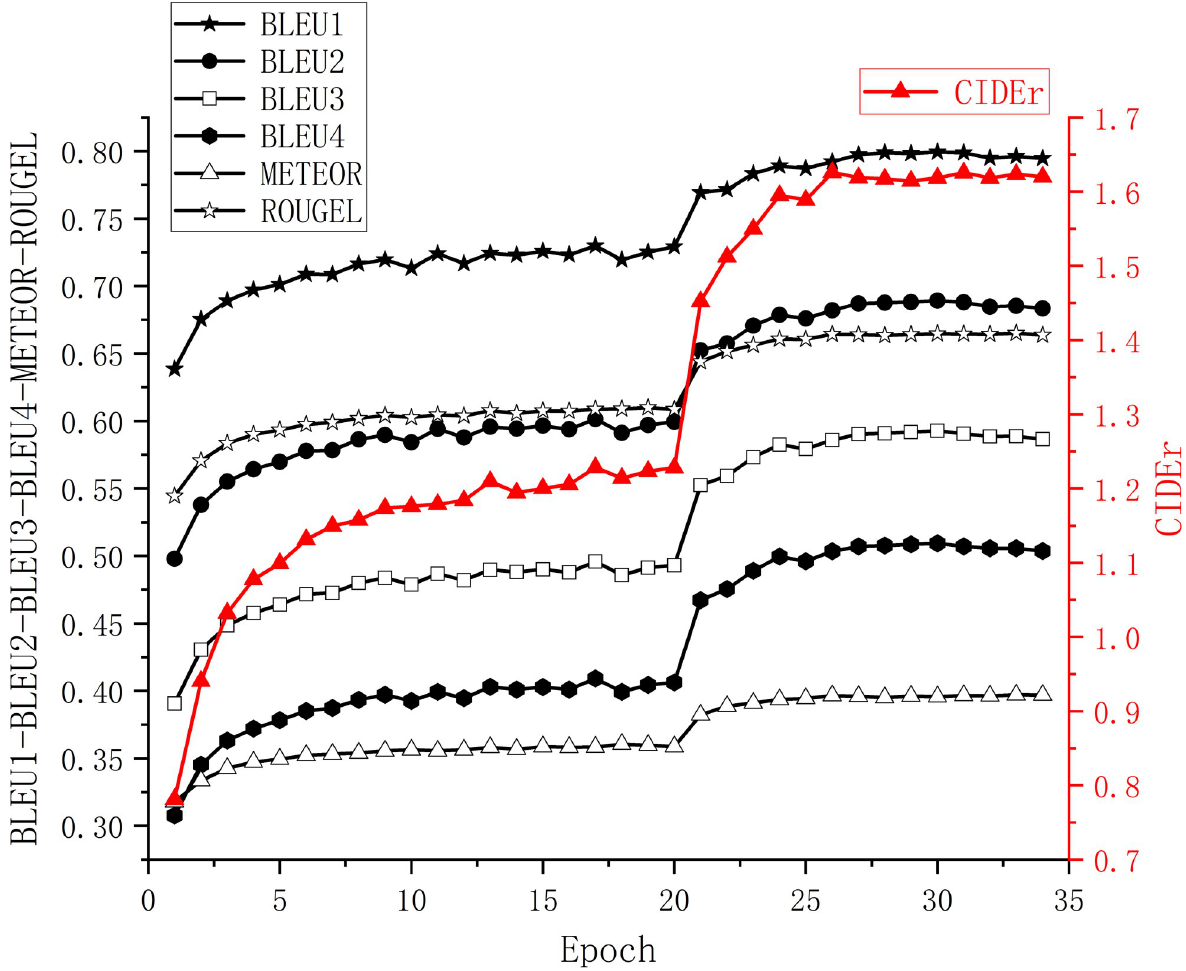
Fig 6. Evaluation score of models in validation